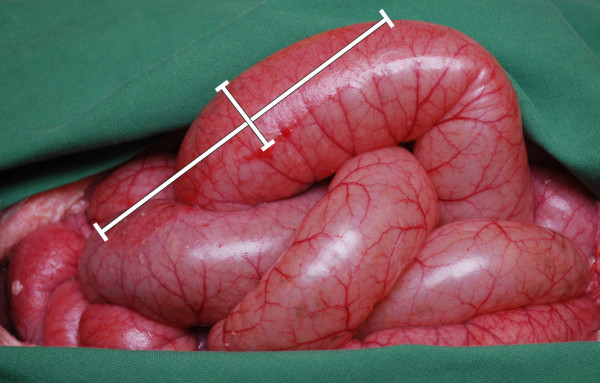
Photograph of the intestines in a porcine open abdominal wound after conventional NPWT at -120 mmHg in the absence of a protective disc between the intestines and the vacuum source. Red, mottled areas can be seen due to intestinal petechial bleeding. The area of bleeding was determined by measuring the length and width.